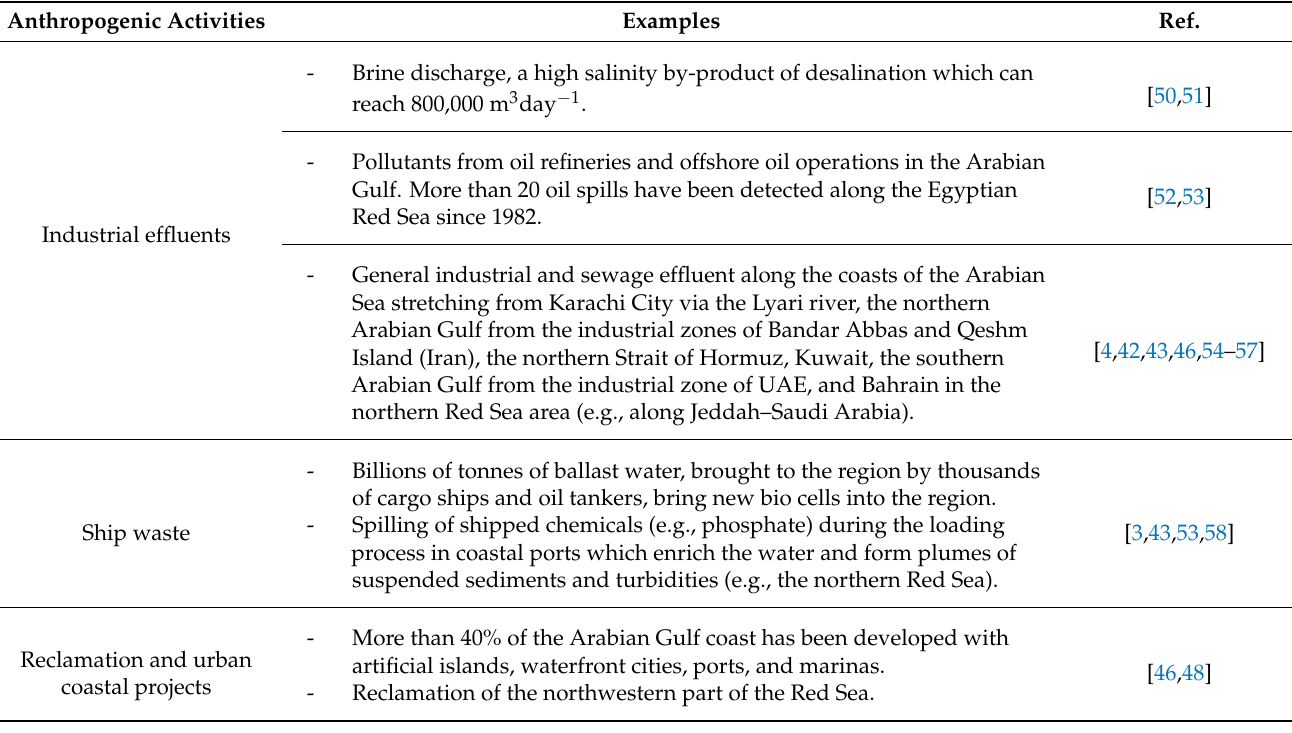
Table 2. Anthropogenic influences on the NIO.